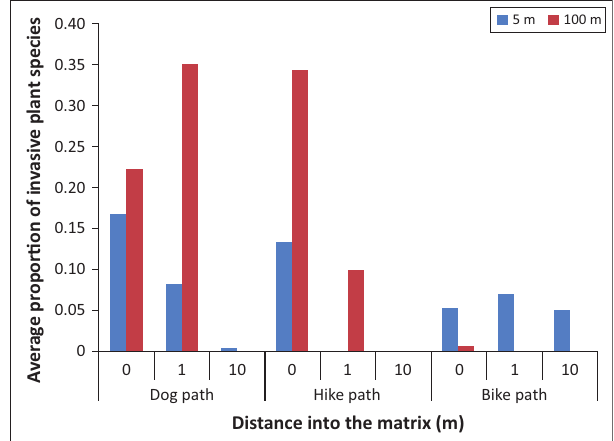
FIGURE 4: The average proportional cover of alien plant species along three different paths in the Silvermine section of the Table Mountain National Park, taken at 0 m, 1 m and 10 m into the matrix and measured at 5 m and 100 m from the